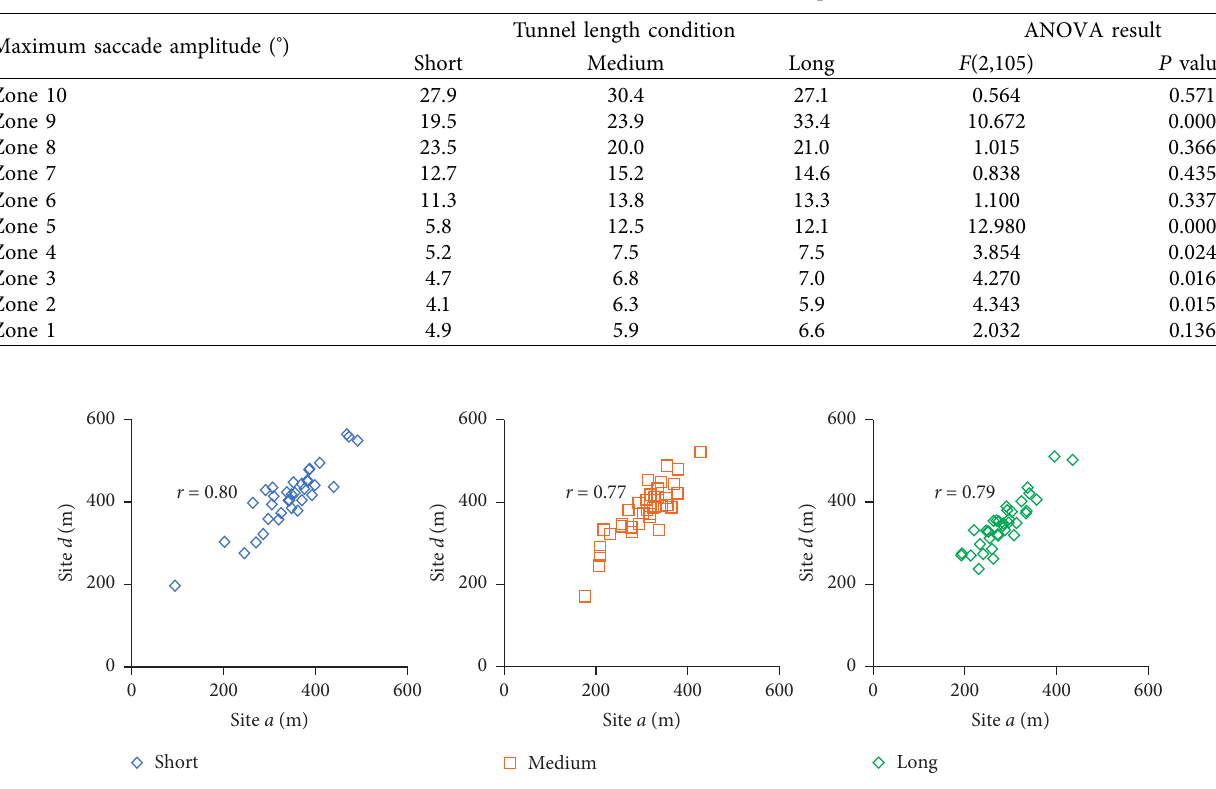
Figure 10: Distribution of drivers’ maximum saccade amplitude among different tunnel length conditions. (a) Short-tunnel condition, (b) medium-tunnel condition, and (c) long-tunnel condition. Table 4: Statistical results for maximum saccade amplitude.